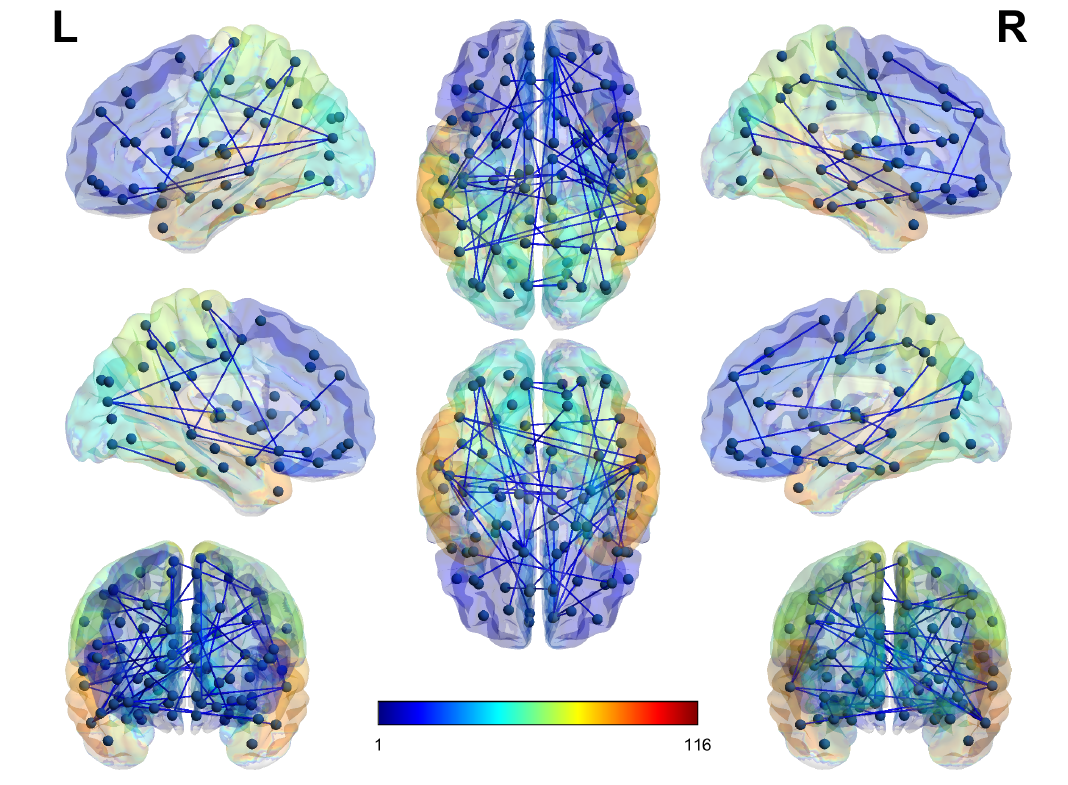
Figure 5. Brain node Connectivity network in Left , Middle and Right areas Using BrainNet-viewer